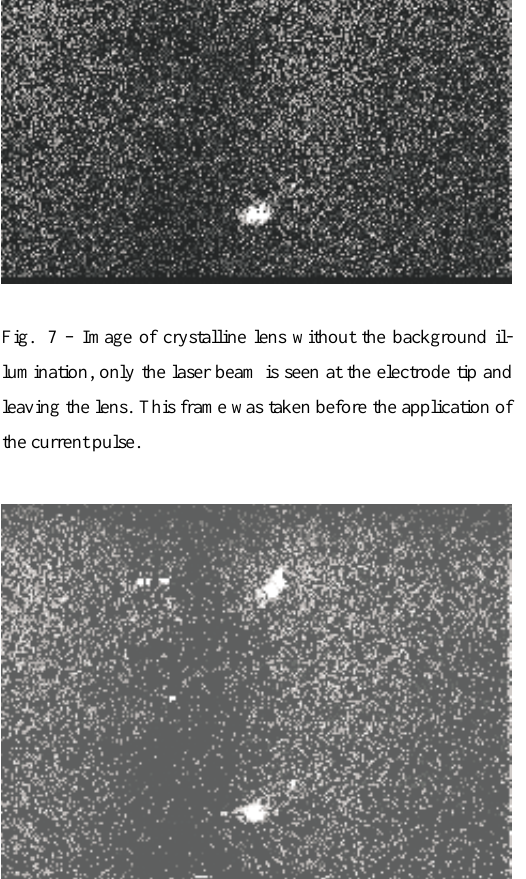
Fig. 10 – Image of the laser beam at the end of the sequence, approximately one second after the end of the pulse. Note that most of the light is scattered around the